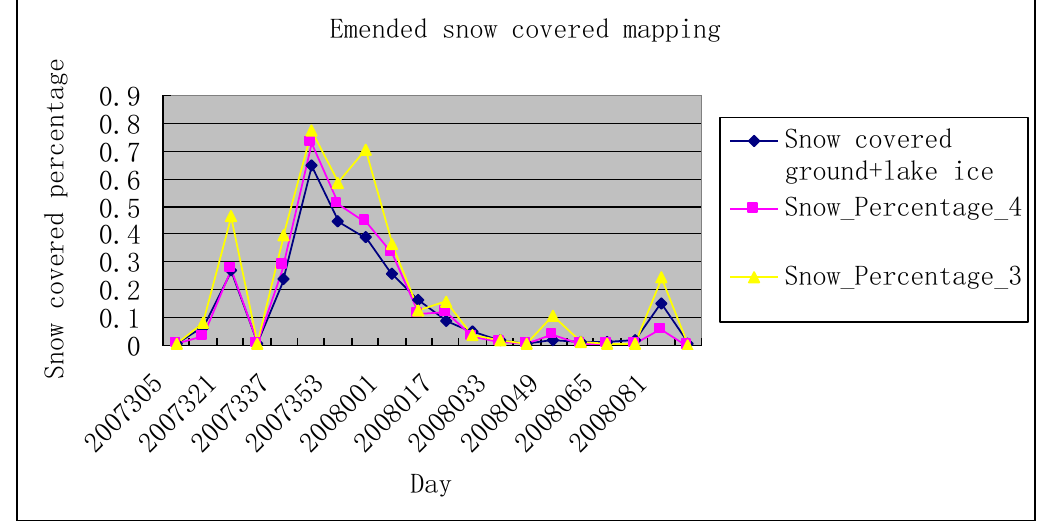
Figure 15. Emended snow covered mapping of 2007–2008 winter. Emended snow covered